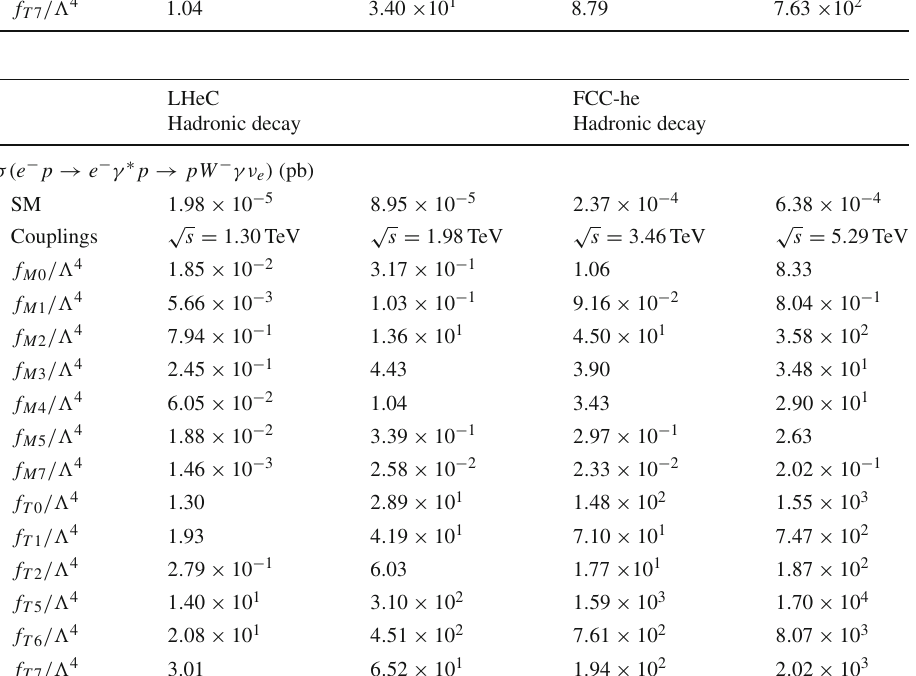
the process e − p → e − γ ∗ p → pW − γν e at the LHeC with